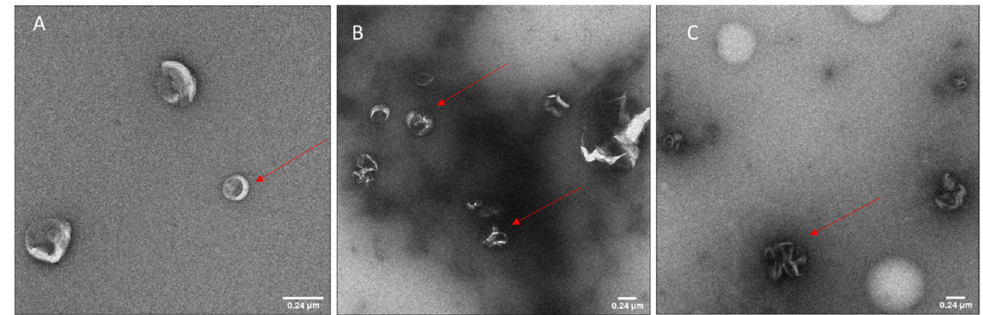
Figure 1. TEM images of blank DOTAP4 liposomes ( A ), DOTAP4-pCMVkan-S 0.25:1 N/P ratio ( B ) and DOTAP4-pCMVkan-S 1:1 N/P ratio ( C ). Bar = 0.24 µ m. Red arrows indicate the presence of liposomes in figure ( A ), and of lipoplexes in figure ( B , C